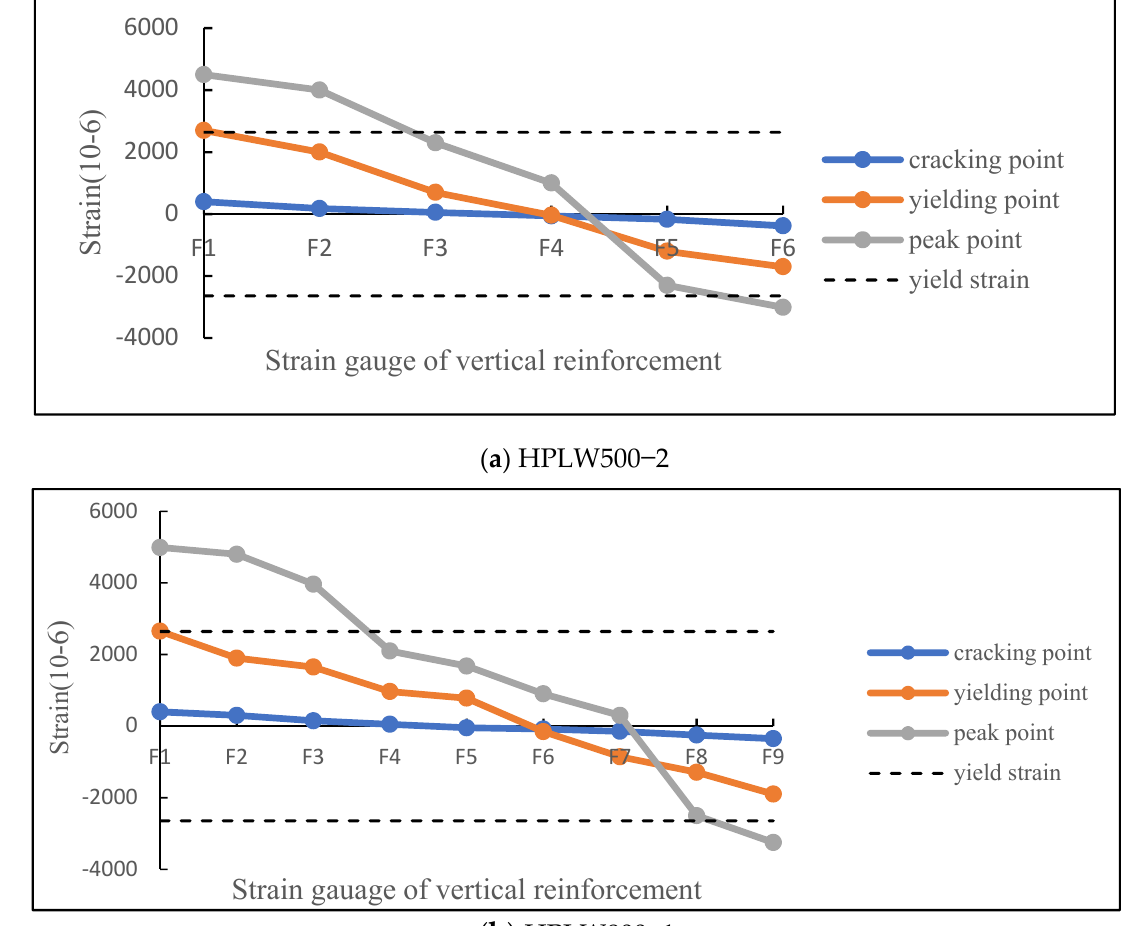
Figure 14. Vertical reinforcement strain distributions along the wall length.